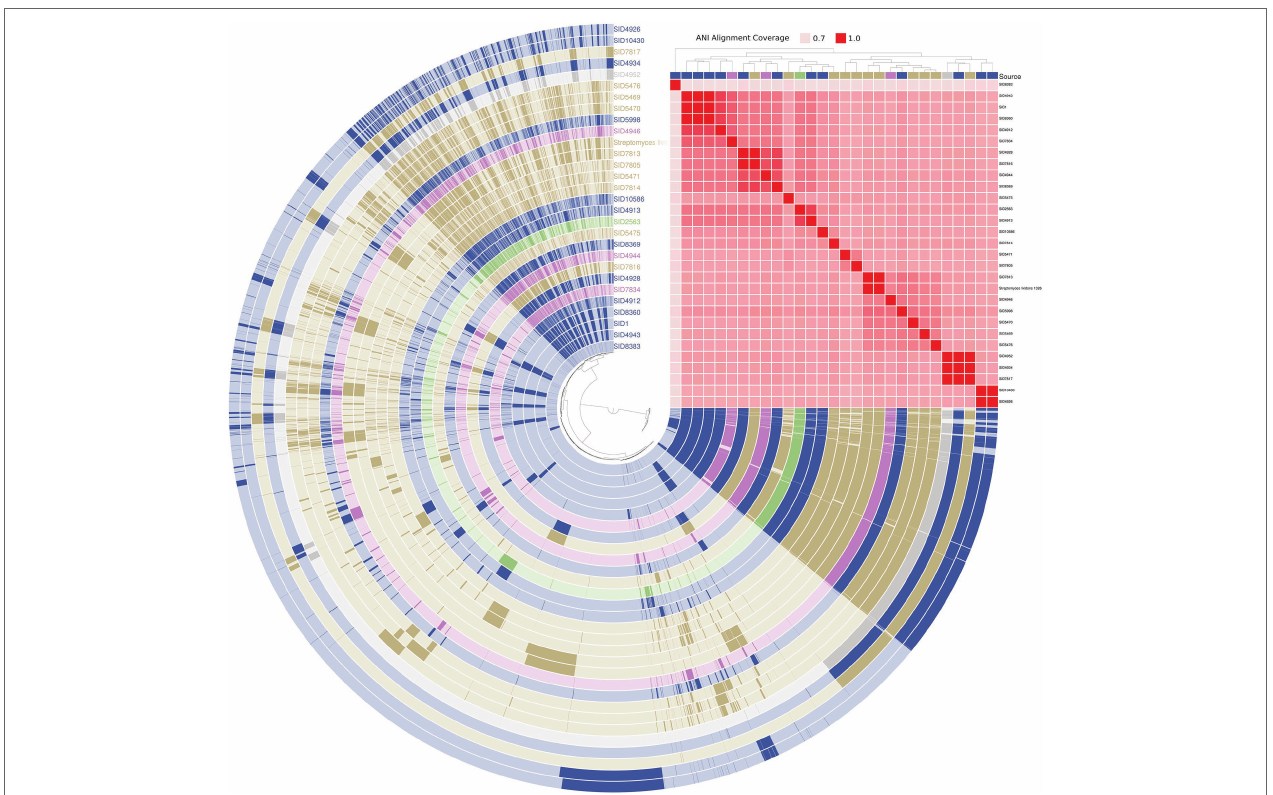
FIGURE 5 | Anvi’o genome map of select Streptomyces . Each rail belongs to an individual genome and is colored according to its source (blue = insect-associated; green = plant-associated; purple = fungi-associated; soil = tan; gray = unknown). Presence (dark shading) and absence (light shading) are shown for all gene content in two or more strains. Strains are arranged by ANI alignment coverage and genes are arranged by presence/absence distance (both Euclidean clustering). Pseudonocardia SID8383 (inner rail) is used as an